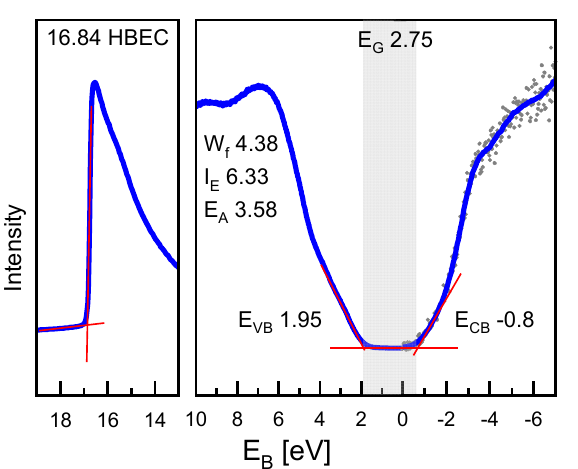
Figure 7. Combined IPES/UPS measurements of the PFN layer deposited on STO/SRO. The band onset, the position of the high binding energy cut-off (HBEC), and extracted energy values are indicated in the graph.